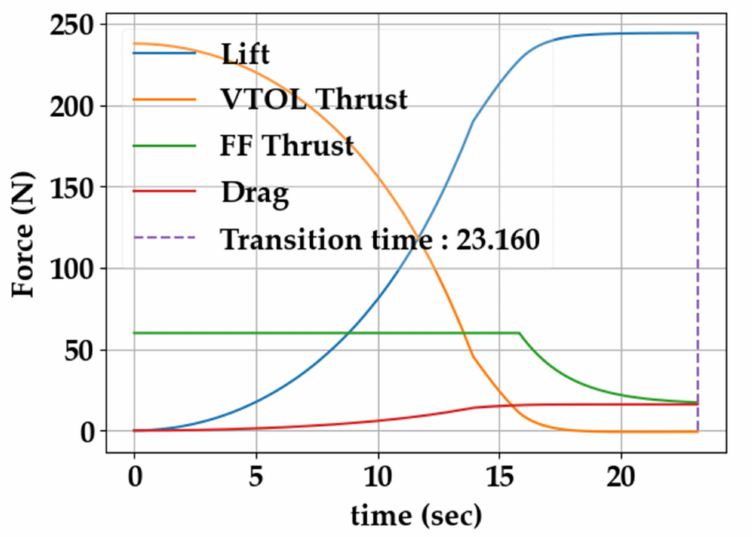
Figure 20. Transition analysis result. This result shows the forces acting on the UAV during its transition. The transition time calculated through analysis satisfied the design requirement as 23.16